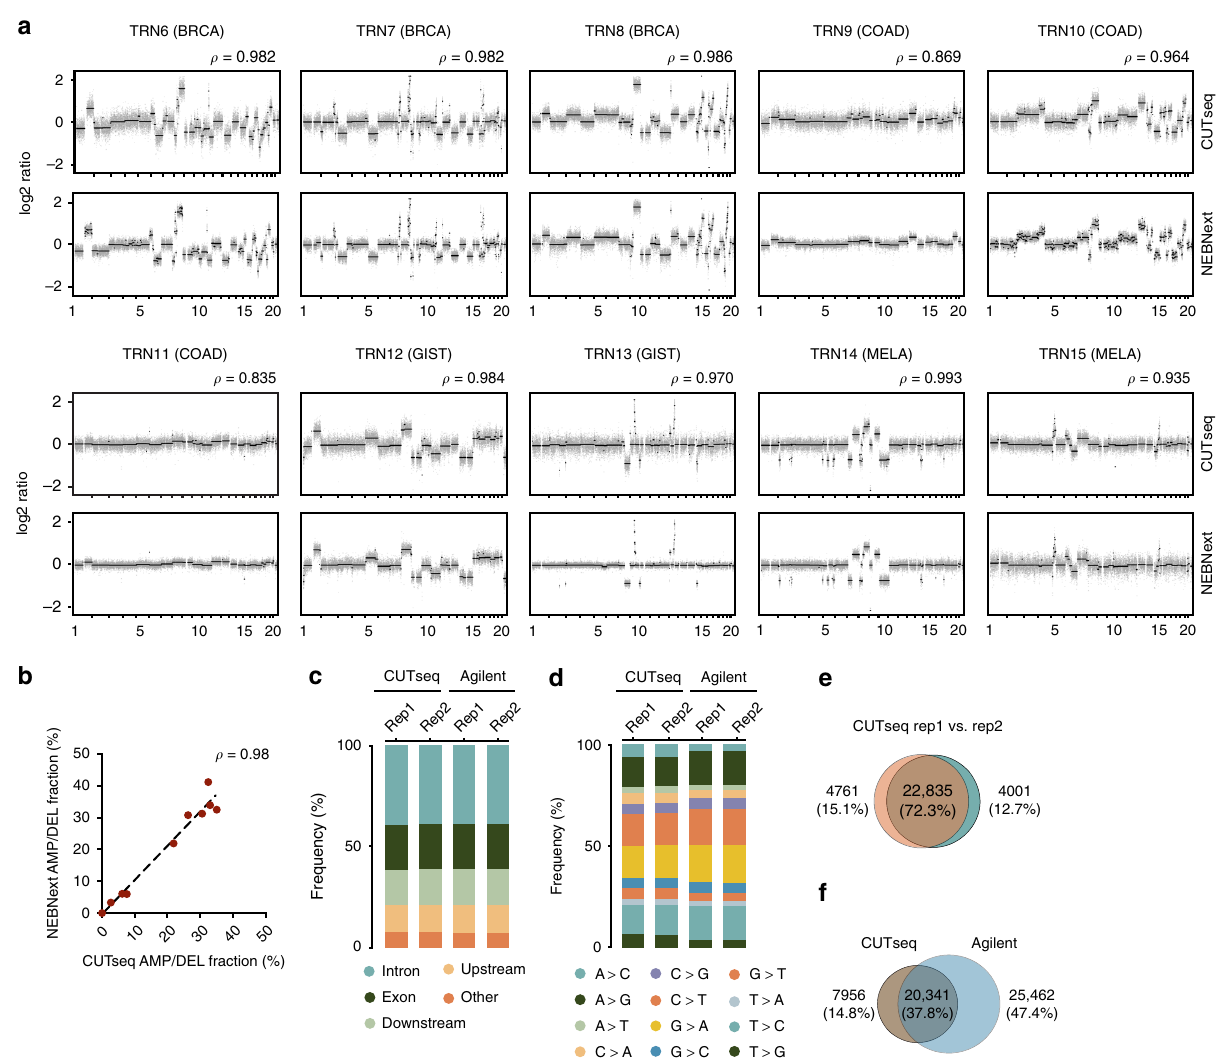
Fig. 2 CUTseq validation. a Copy number pro fi les (NlaIII, 100 kb resolution) determined with CUTseq and NEBNext using gDNA extracted from ten different FPPE tumors. BRCA, breast cancer. COAD, colon adenocarcinoma. GIST, gastrointestinal stromal tumor. MELA, melanoma. ρ , Pearson ’ s correlation between matched pro fi les. b Pearson ’ s correlation ( ρ ) between the fraction of the genome (100 kb resolution) either ampli fi ed or deleted in each of the paired CUTseq and NEBNext samples shown in a . Each dot represents one pair of replicates. Dashed line: linear regression. c Partitioning of all the SNVs called in two replicate (Rep) exome capture experiments using SKBR3 cells gDNA and either CUTseq or a commercial kit for library preparation (Agilent), in multiple different annotated genomic regions. Up- and downstream indicate 5 kb windows before the start codons and after the stop codons of protein-coding genes, respectively. d Same as in c , but for different substitution types. e Overlap between the high-con fi dence SNVs (at least 50× coverage) called in the two CUTseq replicates shown in c , d . f Overlap between all the high-con fi dence SNVs identi fi ed by CUTseq vs. Agilent, after merging matched replicates shown in c , d . In both e and f , the percentages refer to the total number of SNVs in the union of the two sets. All the